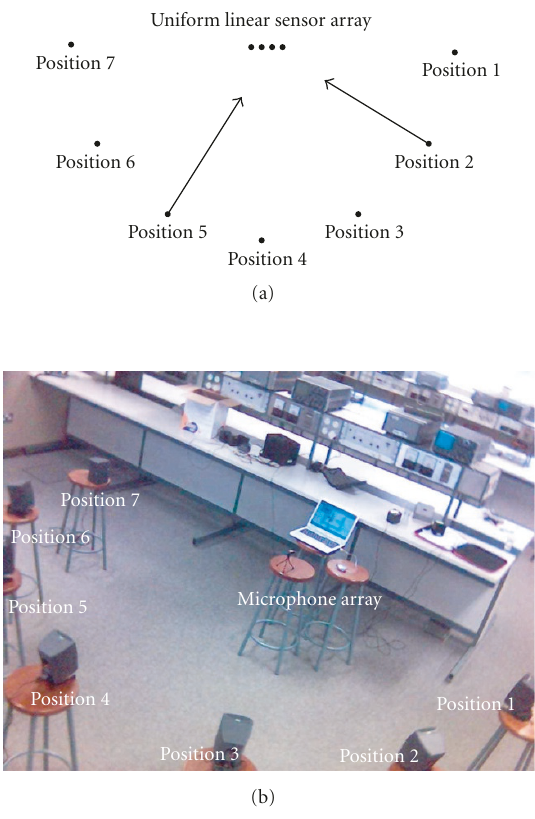
Figure 9: Real-room blind source separation